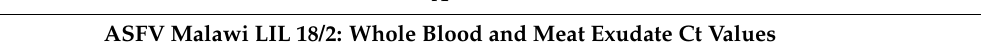
Table 1. Side-by-side Ct values of the whole blood and meat exudate from pigs infected with ASFV Malawi LIL 18/2 or ASFV Estonia 2014.